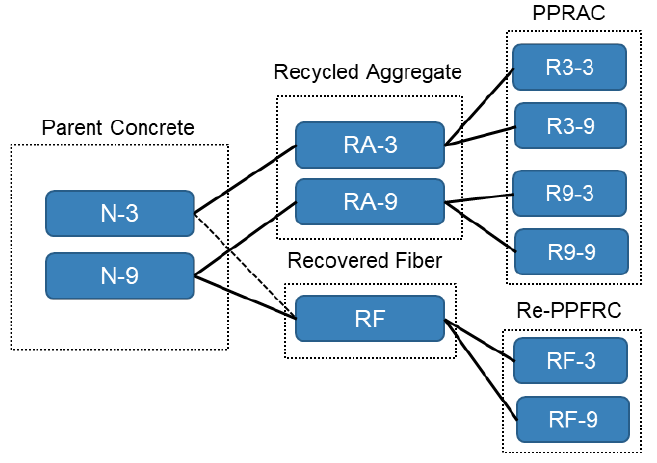
Figure 1. Outline of the experimental study.